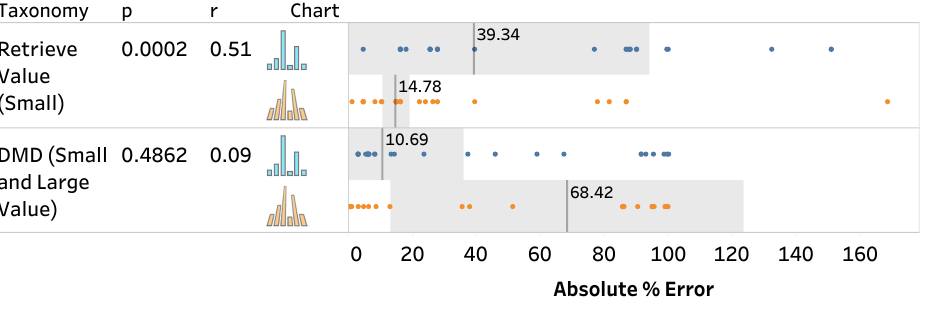
Figure 8. Absolute percentage of error for both taxonomies across both techniques. The central bar inside the grey box represents the median error rate. Each dot represents the error rate of an individual